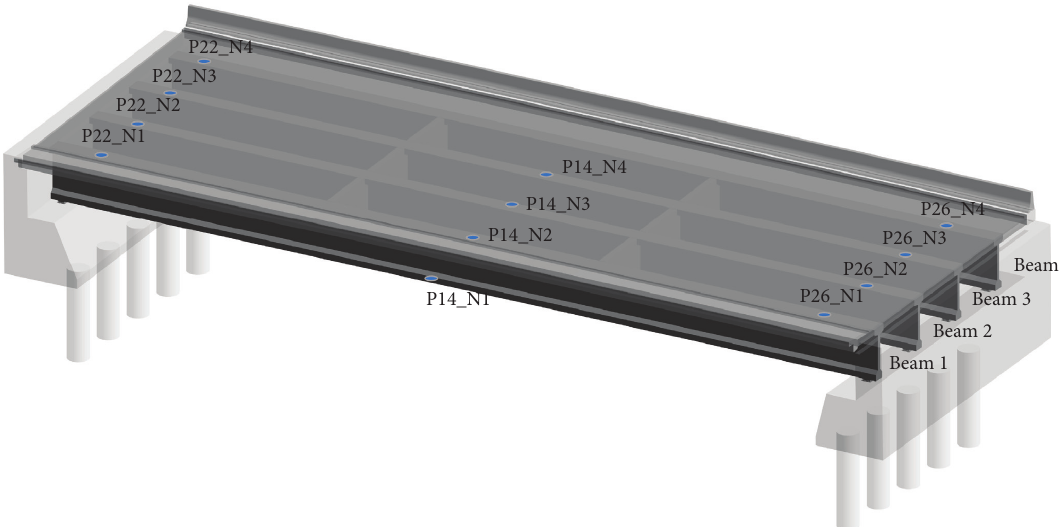
Figure 9: Example IFC model of a beam with